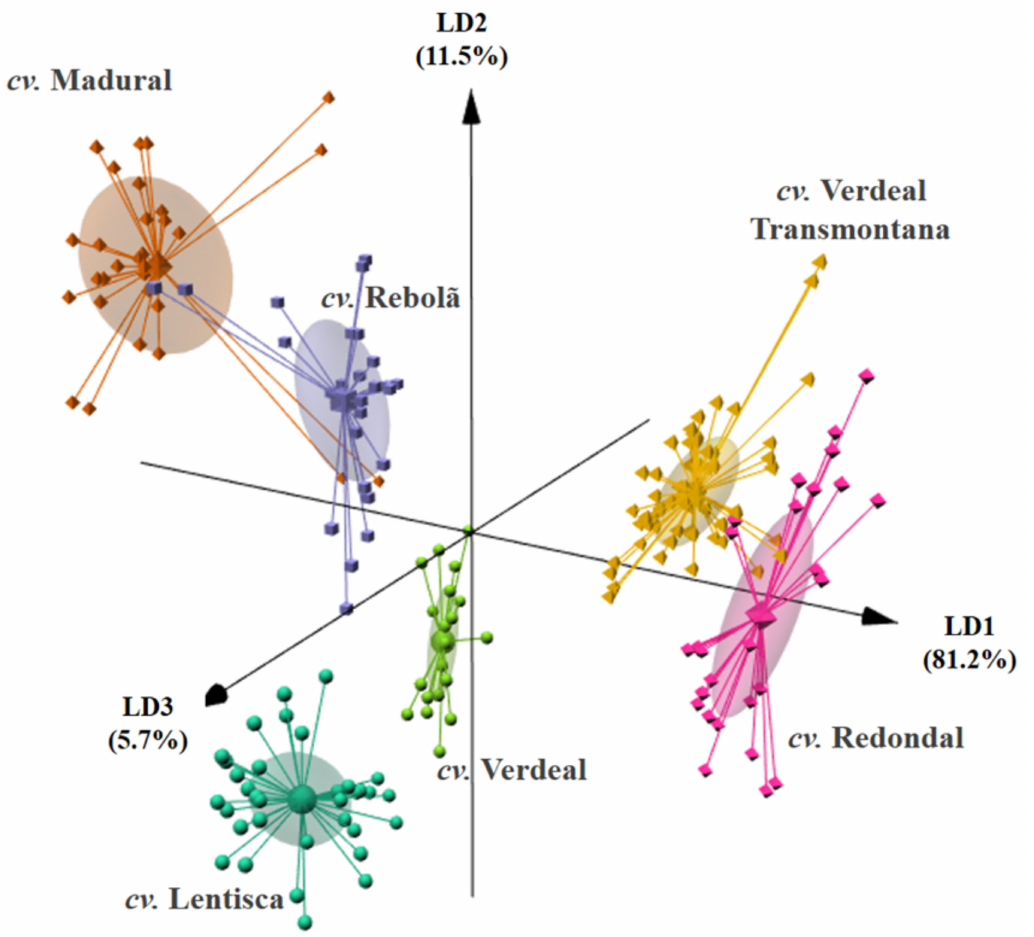
Figure 2. Linear discriminant analysis (LD1: 81.2%, LD2: 11.5%, and LD3: 5.7%): 3D biplot showing the discrimination of olive oil according to olive cultivar (cvs. Lentisca, Madural, Rebol ã , Redondal, Verdeal, and Verdeal Transmontana) on the basis of the proportions (%) of nine fatty acids (C 16:0 , C 16:1 , C 17:0 , C 17:1 , C 18:0 , C 18:1 , C 20:0 , C 20:1 , and C 22:1 ) and PUFA (selected using the simulated annealing algorithm) found in olive oils obtained from olives collected in centenarian trees during five consecutive crop years (2013 to